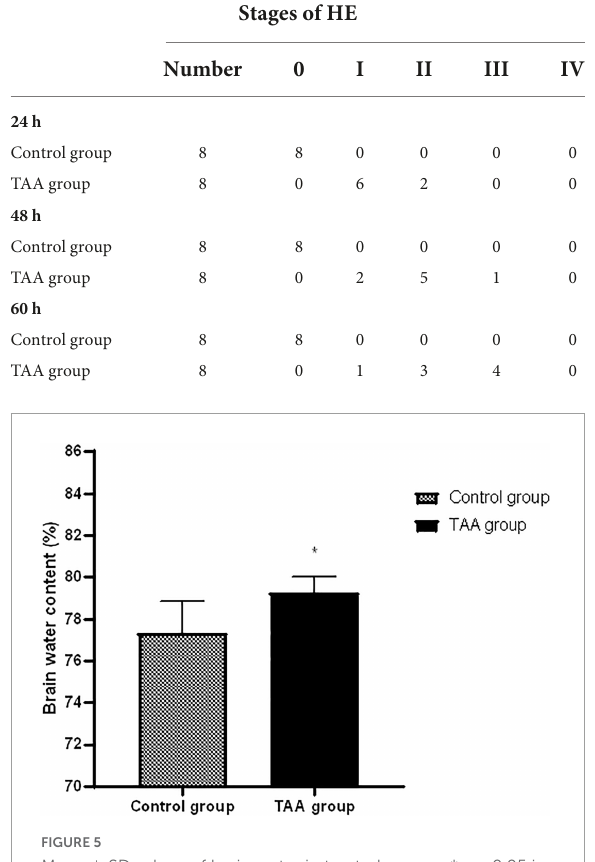
FIGURE5 Mean ± SD values of brain water in treated groups. * p < 0.05 is significantly different in the TAA-treated group compared to the control